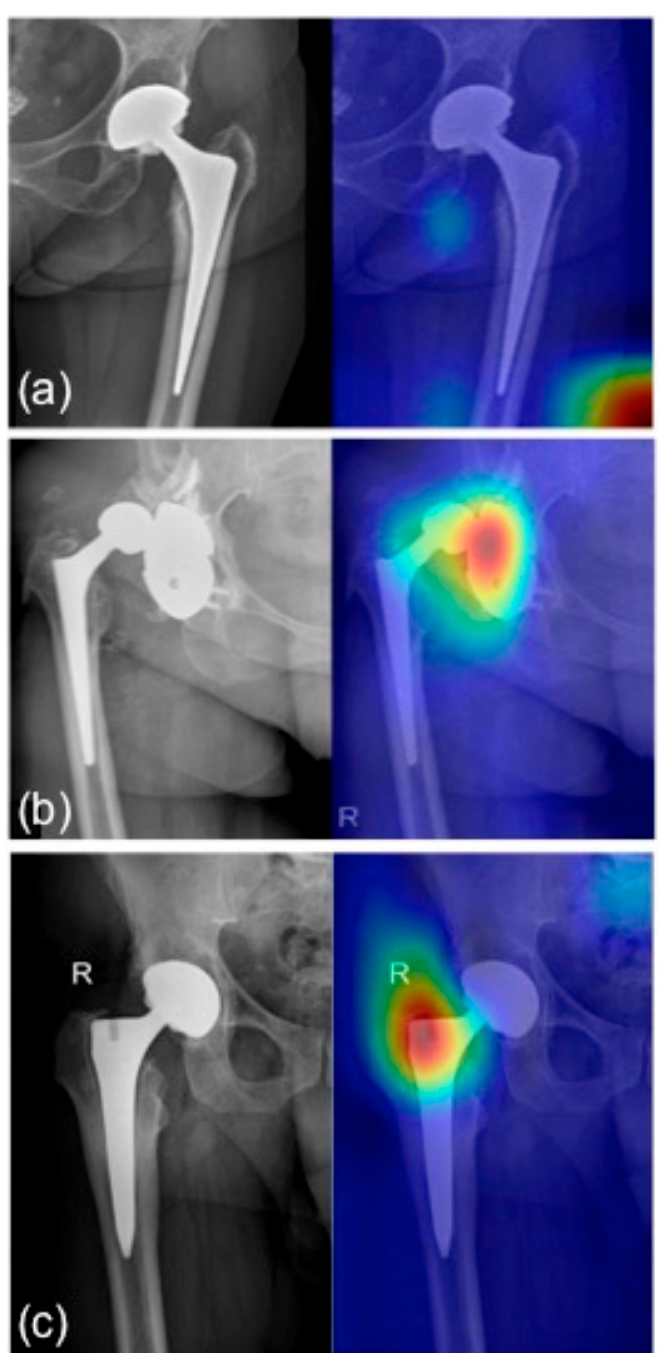
Figure 6. Grad-CAM for ( a ) healthy prosthesis heatmap: no regions in the image are lighted up with warm colors; ( b ) pathological acetabular heatmap: acetabular cup dislocation glows in red; ( c ) pathological stem heatmap: pathological traits are highlighted in the stem region. R: right side. Table 1. Performance in training, validation, and test sets.